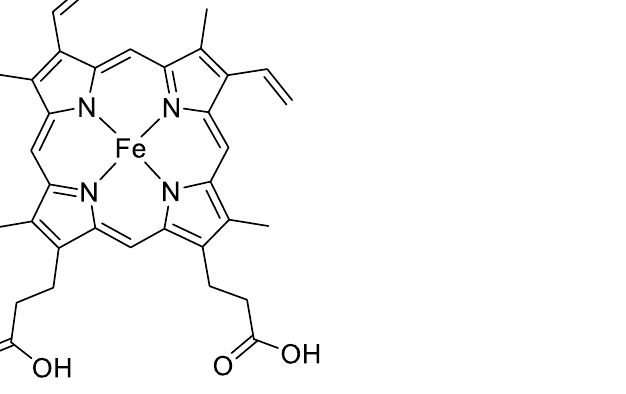
Figure 3. Structure of protoheme IX (heme b) 39